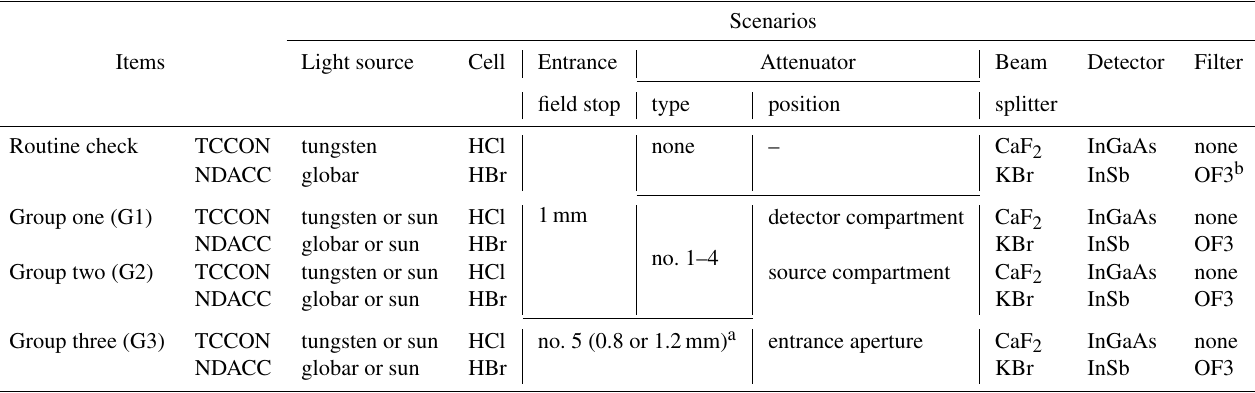
Table 1. Optical scenarios for each ILS monitoring.